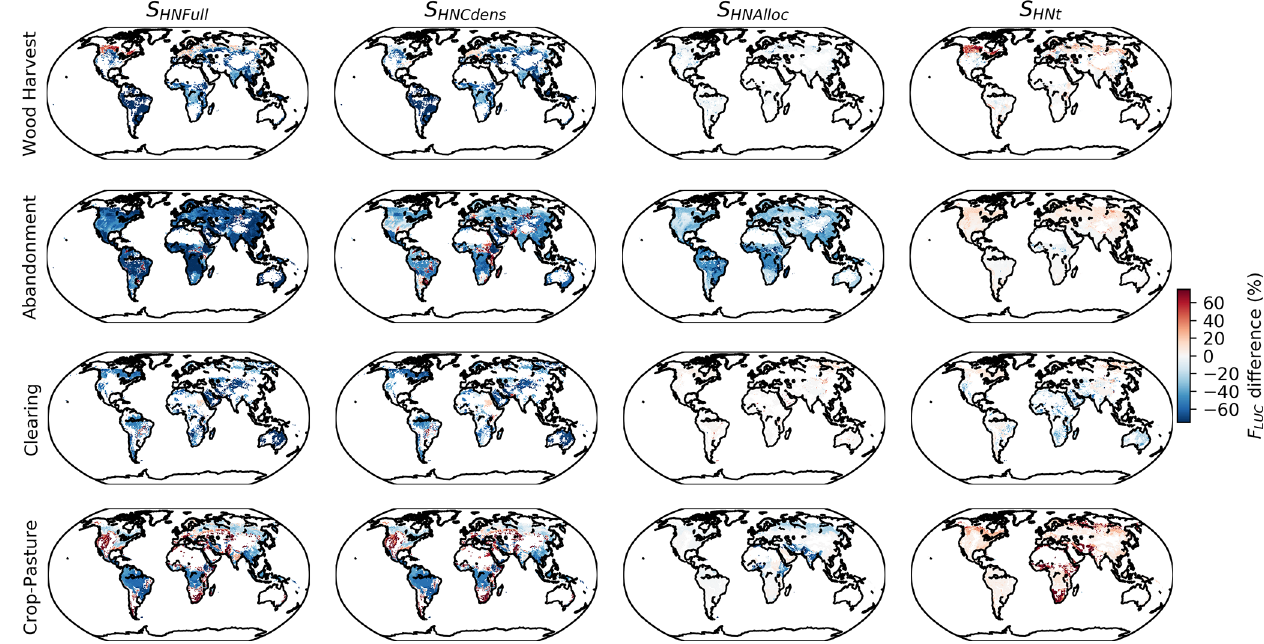
Figure 5. Spatial distribution of relative differences in average F LUC between 1850–2018 for each of the four simulations with HN2017 parameters ( S HNFull , S HNCdens , S HNAlloc , S HNt ), compared to S BL-Net for different F LUC components: wood harvest, abandonment, clearing and crop–pasture transitions. Regions with average low values of F LUC (e.g. deserts) are